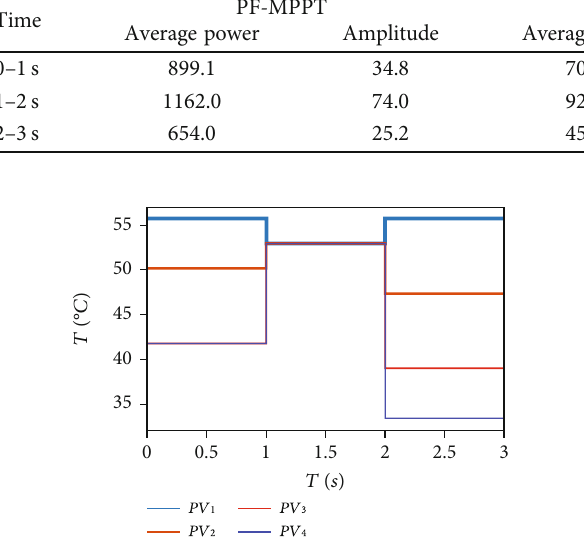
Figure 20: Temperature variations of photovoltaic